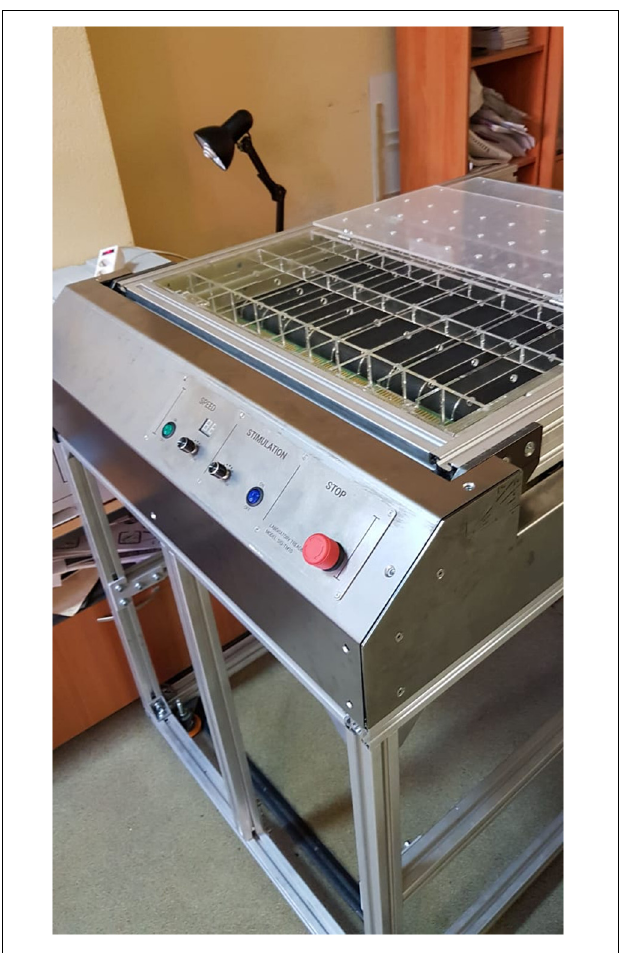
FIGURE 2 | BMELAB SID-TM10